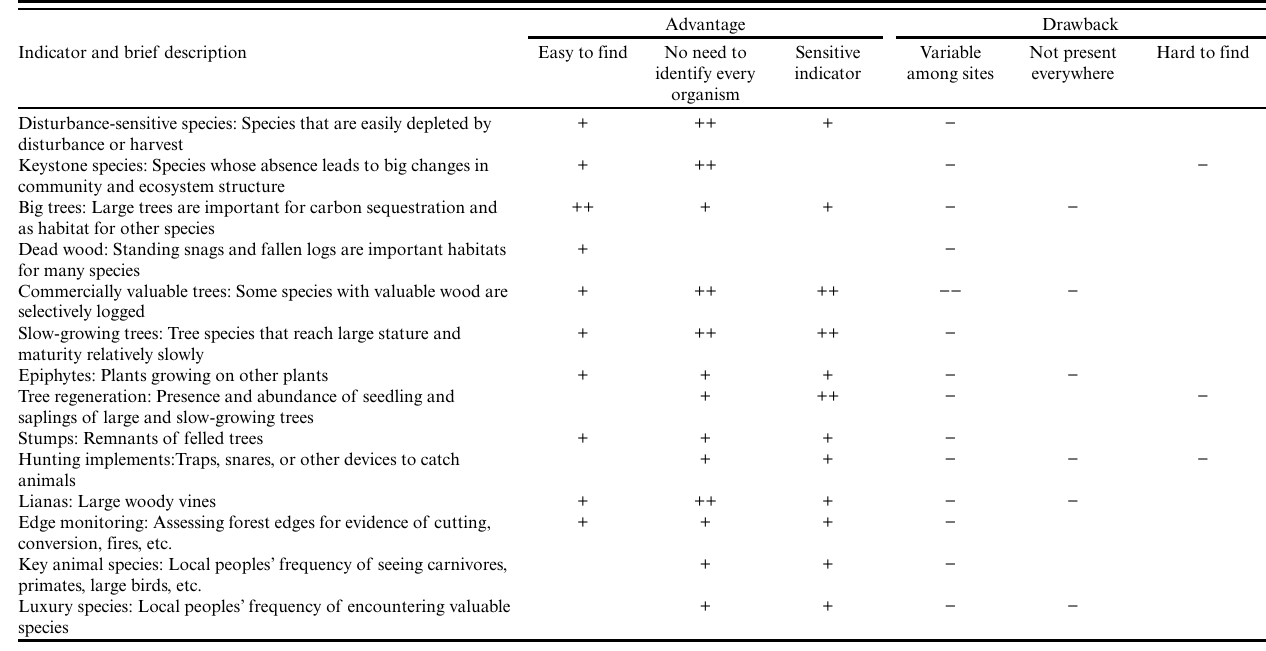
Table 1. A summary of the suggested potential indicators of forest state. The number of pluses or minuses indicates the authors’ views on the strength of a particular advantage or disadvantage.